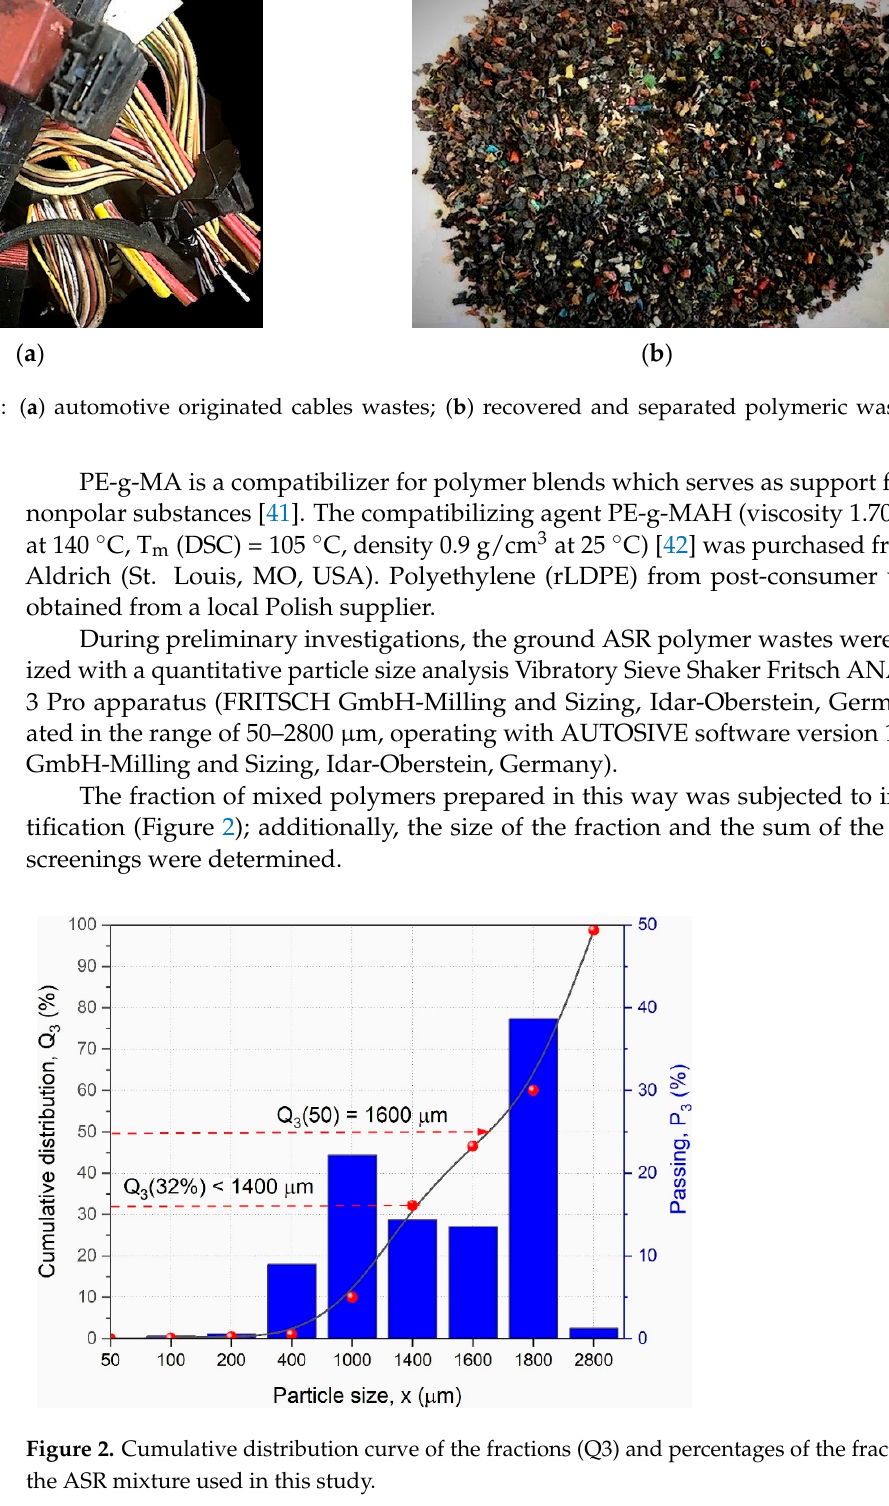
Figure 2. Cumulative distribution curve of the fractions (Q3) and percentages of the fractions (P3) of the ASR mixture used in this